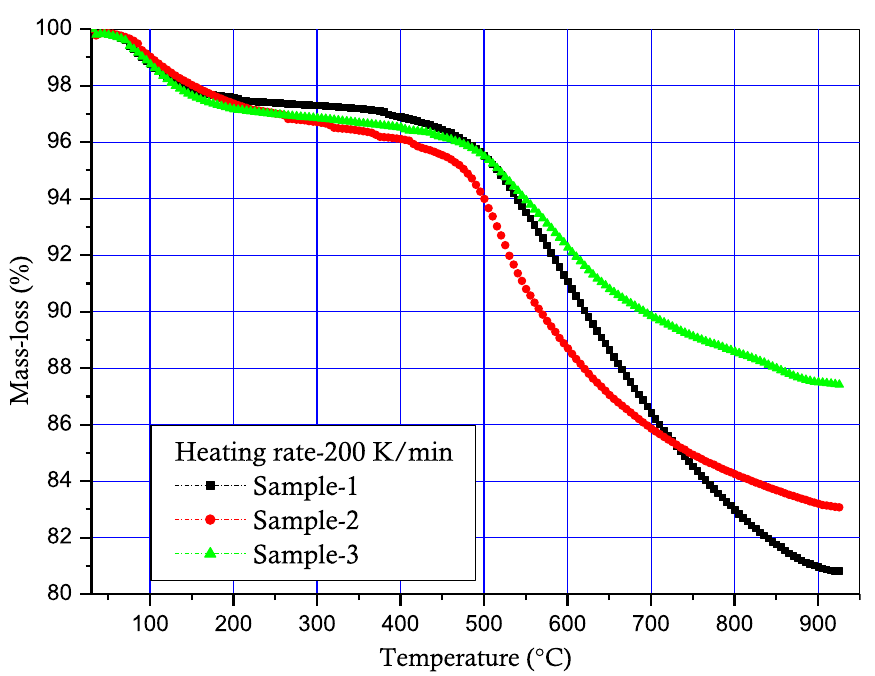
Fig. 3 TG curves for low rank coal at heating rate 150 K/min